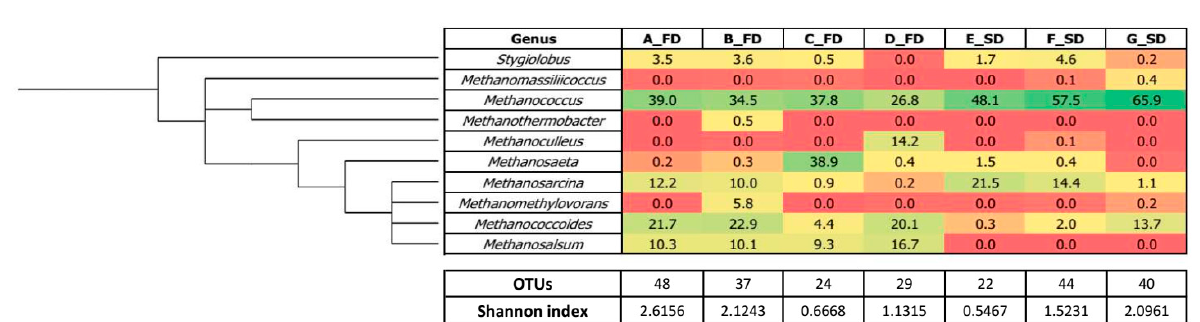
Figure 2. The archaeal genera share and phylogenic tree of seven full-scale anaerobic digestion plants treating food waste and sewage sludge (OTUs—operational taxonomic units). Table 2. Metabolic association of archaea observed in seven full-scale anaerobic digestion plants